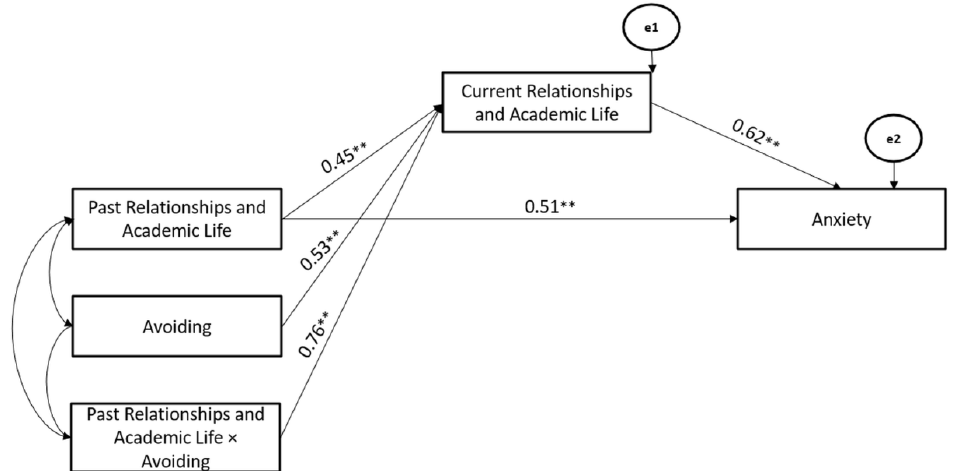
Figure 3. The Mediated-Moderated model of Past and Current Relationships and Academic Life stressors, Avoiding Coping Strategy, and Anxiety. ** p < 0.01.